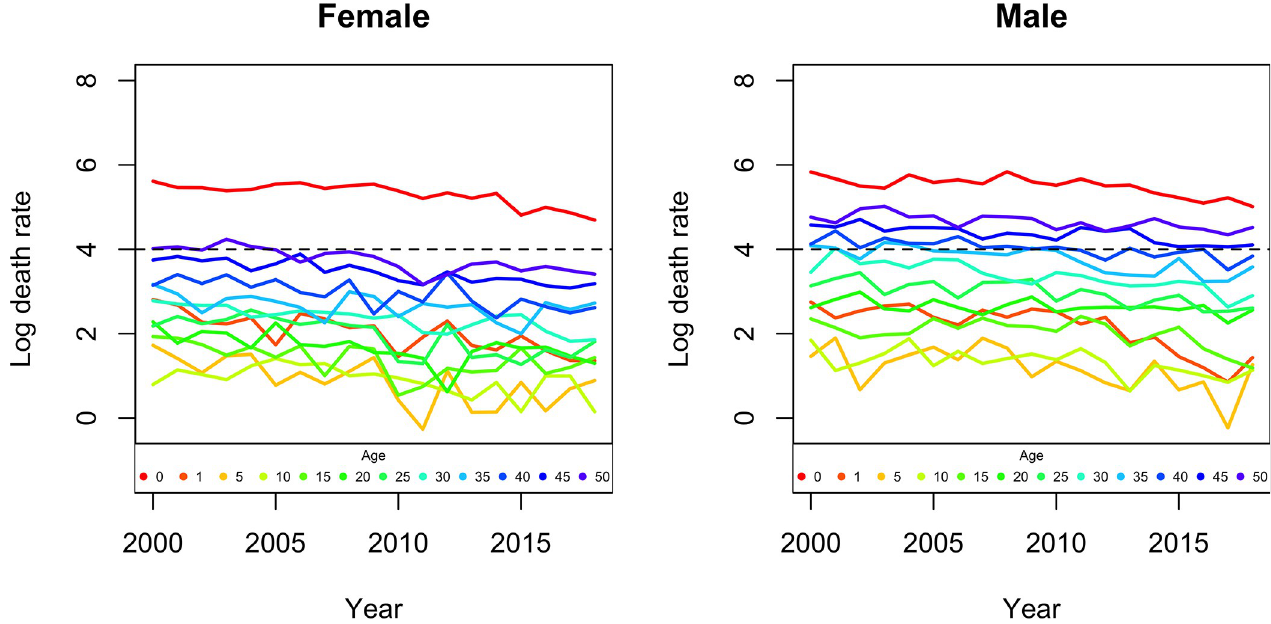
Fig 4. Age-specific mortality rate (0 to 50 years) and